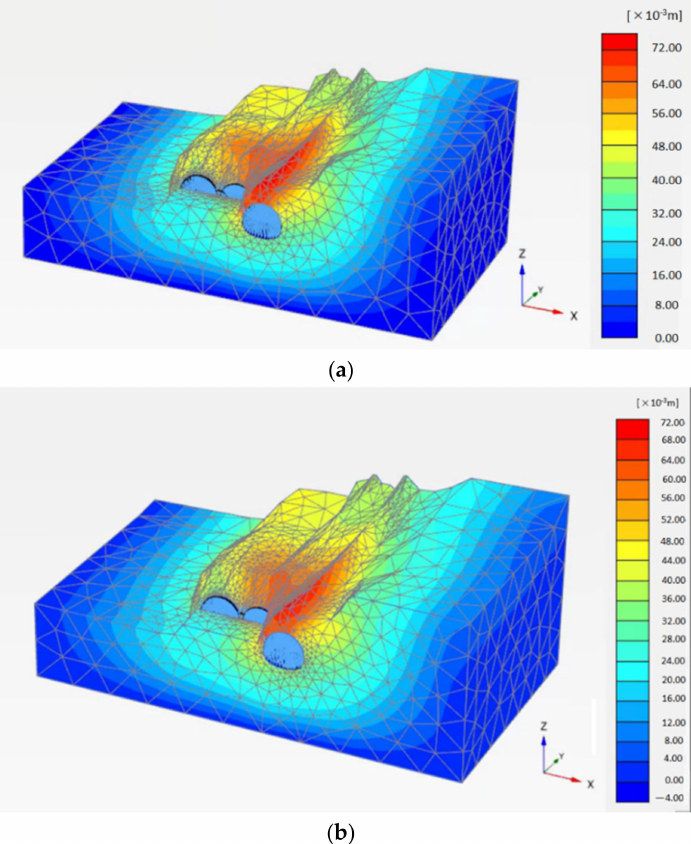
Figure 33. Shading distribution diagram of total displacement of the surrounding rock in the final excavation stage: ( a ) without rock bolts and ( b ) with rock